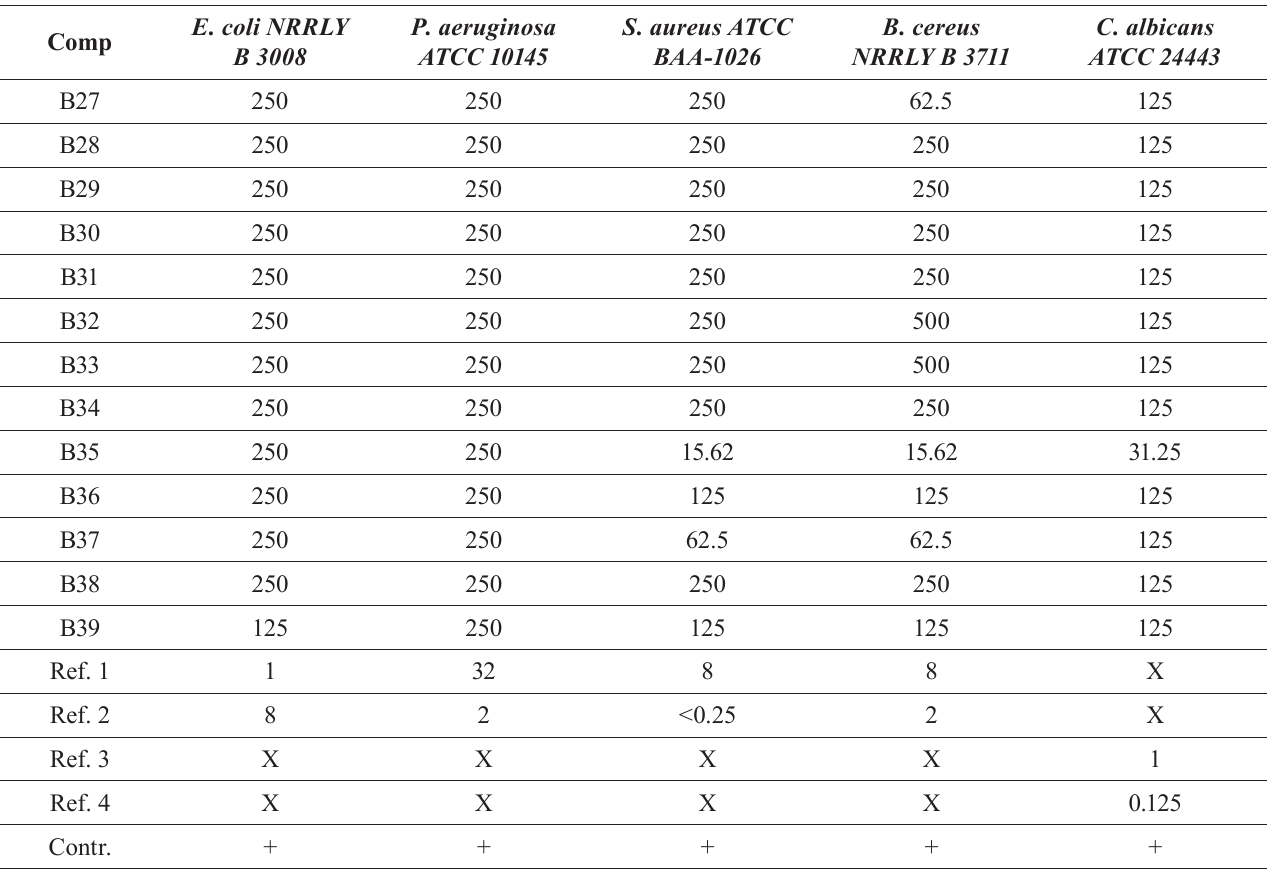
TABLE II – MIC (µg/mL) of the compounds series V(A1-A24, B1-B39)